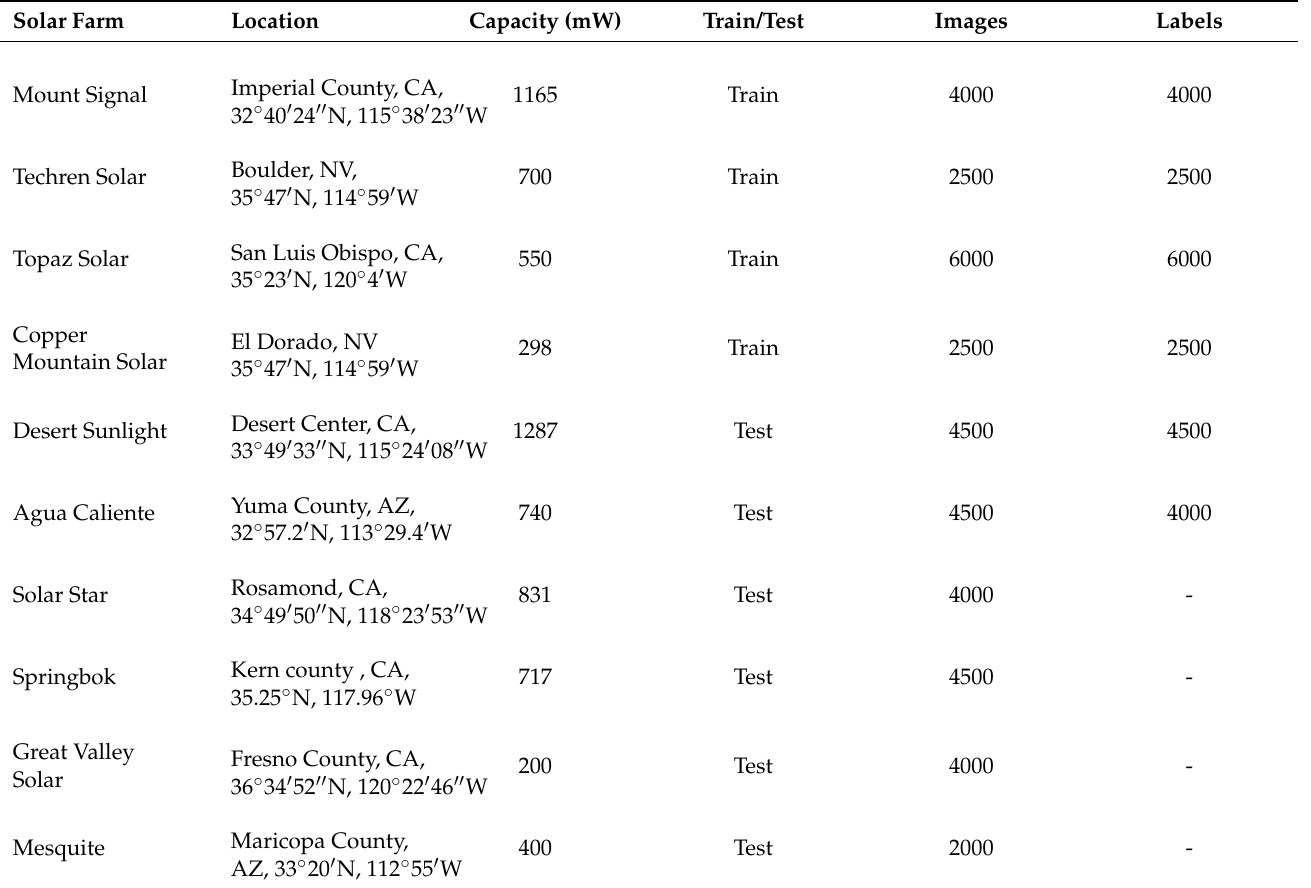
Table 1. Composition of the dataset. Some labeled and unlabeled solar farms are reserved exclusively for testing as an additional check for robustness and generalizability. The labeled portion of the dataset consists of 23,500 images, along with their corresponding labels/masks ready for